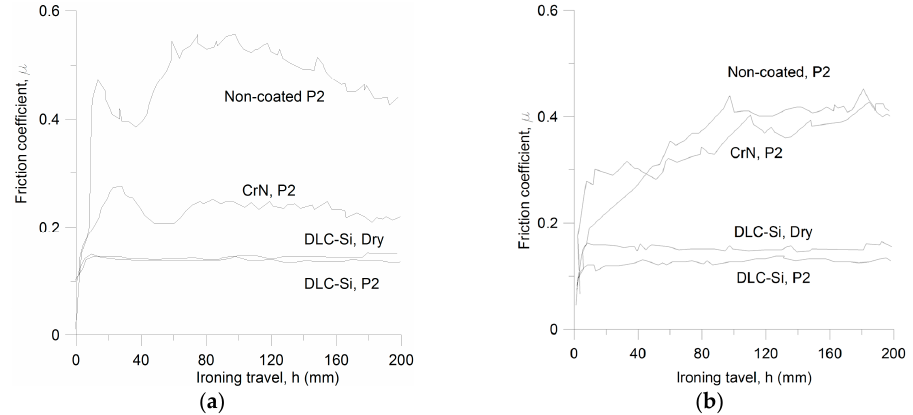
Figure 15. Variation of friction coefficient during ironing with a 20% reduction ( a ) SPFC590, after ref. [31]; ( b ) C2801-1/4H after ref. [31]. Table 3. Experimental results from ref. [32].